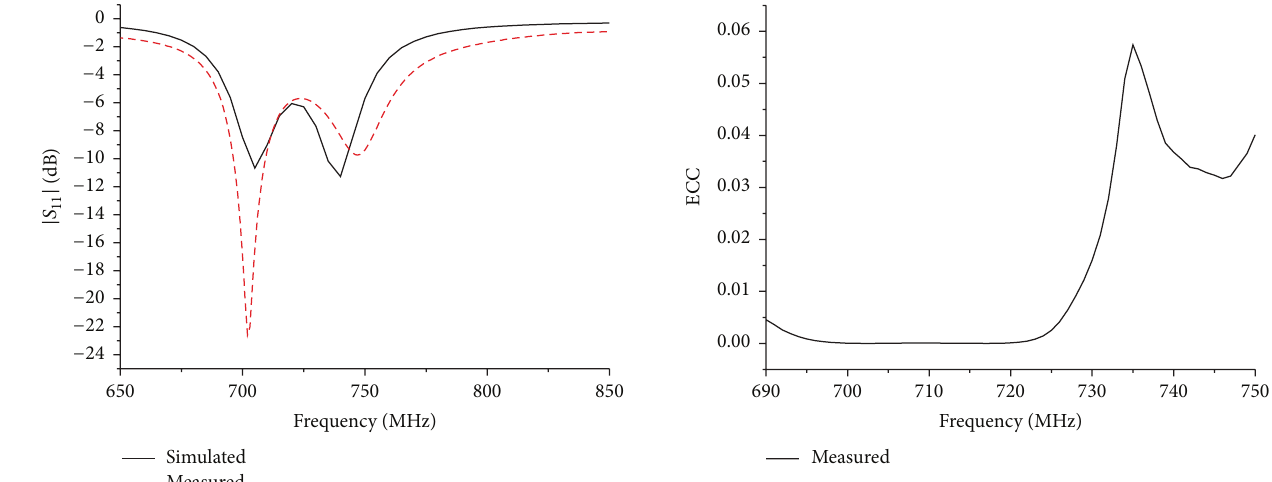
Figure 10: Measured ECC of the proposed